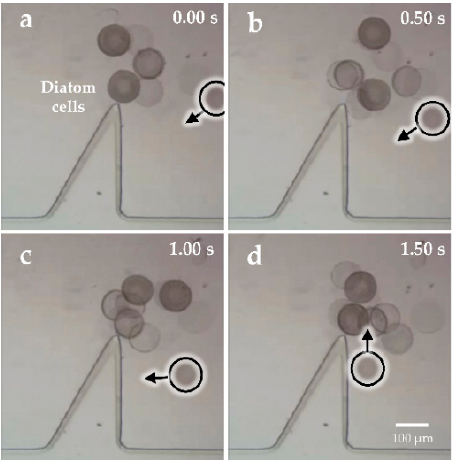
Figure 11. ( a – d ) Microscopic images showing the time necessary to trap a diatom at the distance of 400 μ m.